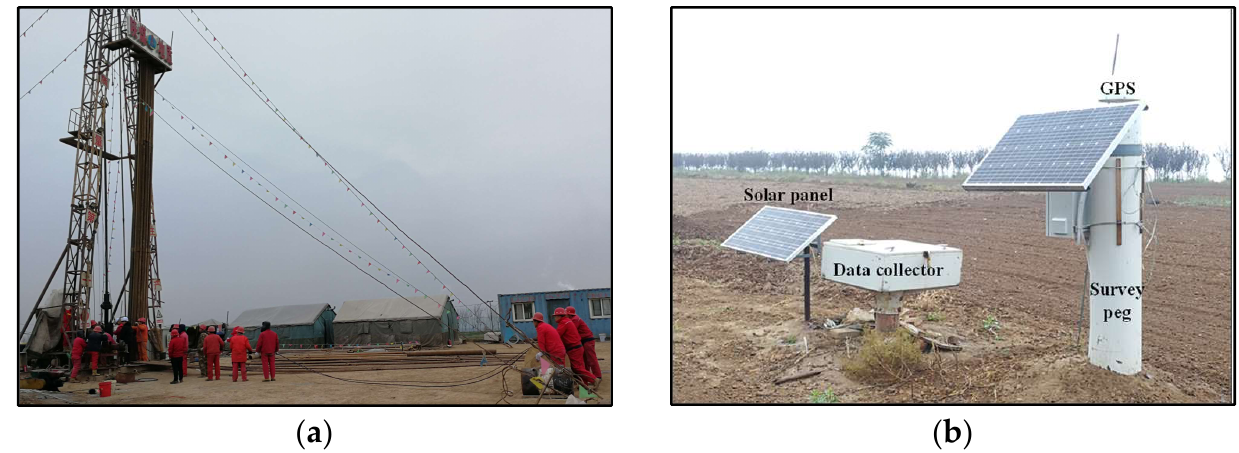
Figure 7. Drilling construction and monitoring system after installation: ( a ) Drilling construction and ( b ) monitoring system.